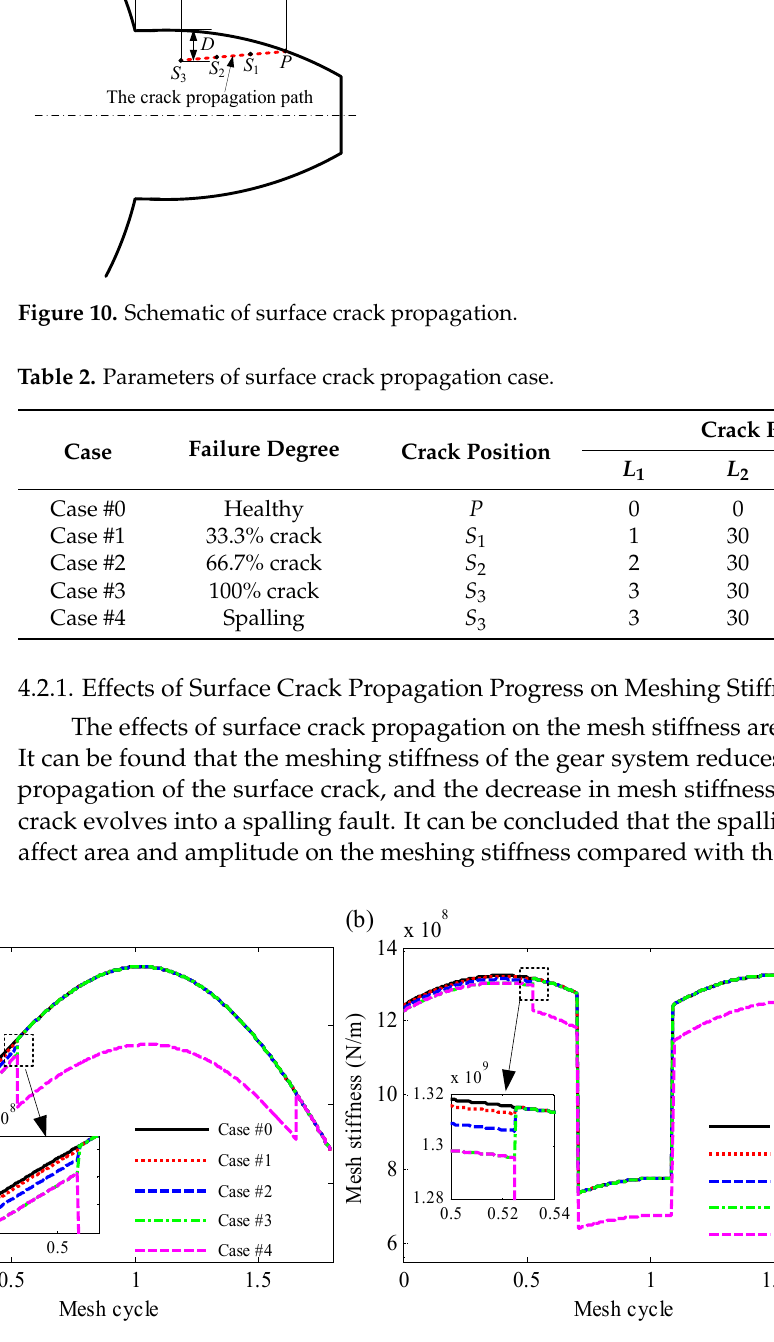
Figure 11. Effects of surface crack propagation on meshing stiffness: ( a ) single ‐ tooth pair, ( b ) double ‐ tooth pairs.